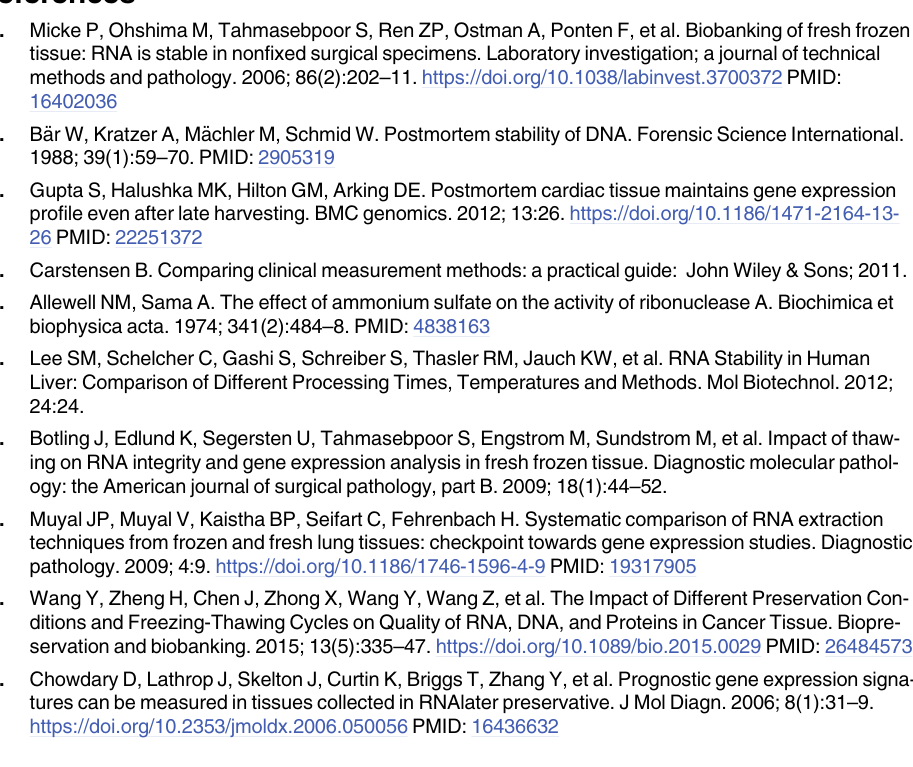
S1 Table. Influence of cold ischemic time and asservation procedure on RNA quality. S2 Table. RNA quality after thawing and